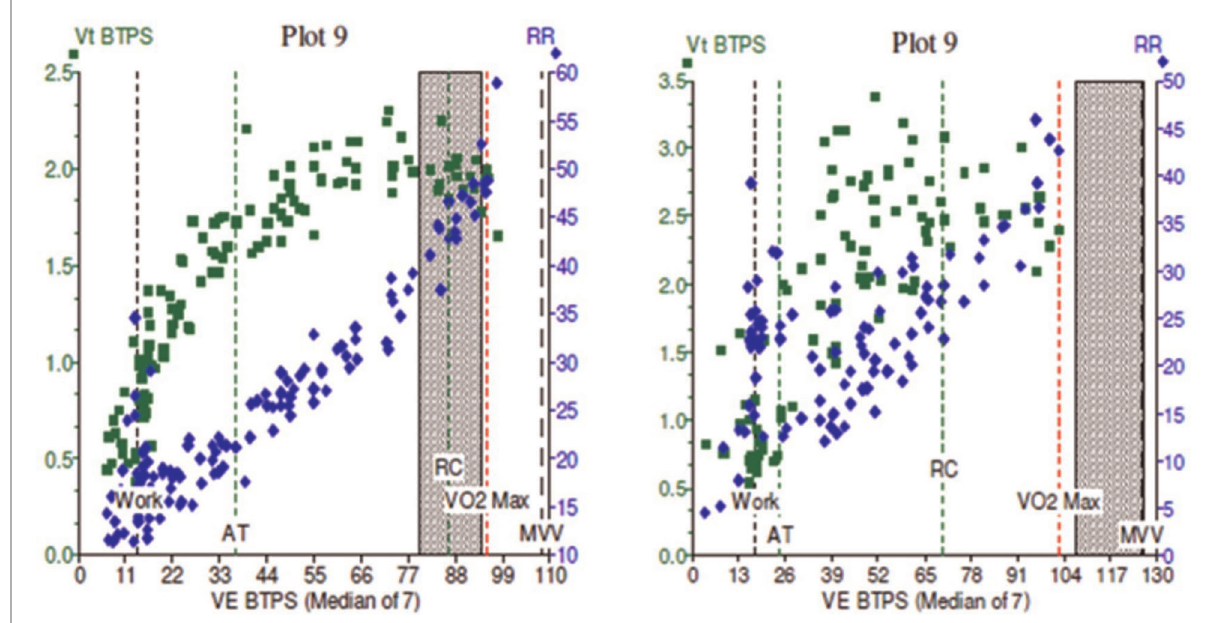
FIGURE 6 Cardiopulmonary exercise test (CPET) plots of minute ventilation (VE, x axis) against tidal volumes (Vt, y axis) in two patients. In ( A ), the green squares demonstrate a normal physiological response to incremental exercise, with increase Vt initially followed by increasing VE in a healthy subject. In ( B ), exercise was limited by dysfunctional breathing, with erratic, non-linear relationship between Vt and VE which becomes more noticeable at higher